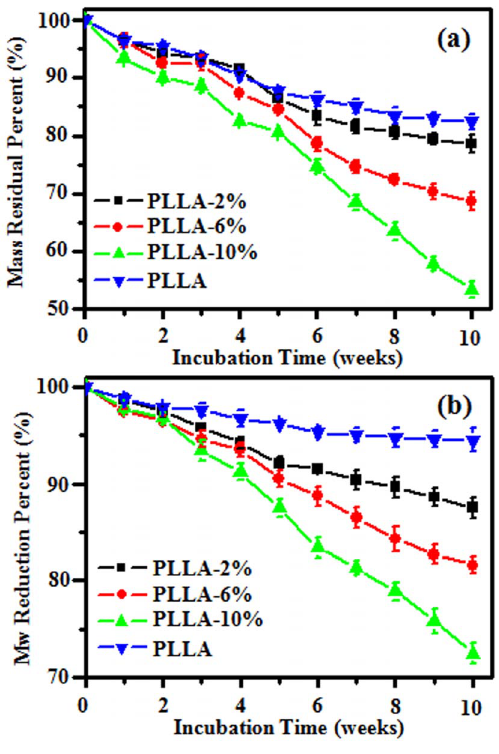
Figure 5. Residual mass percent (a) and molecular weight reduction (b) of electrospun fiber scaffolds after incubating in